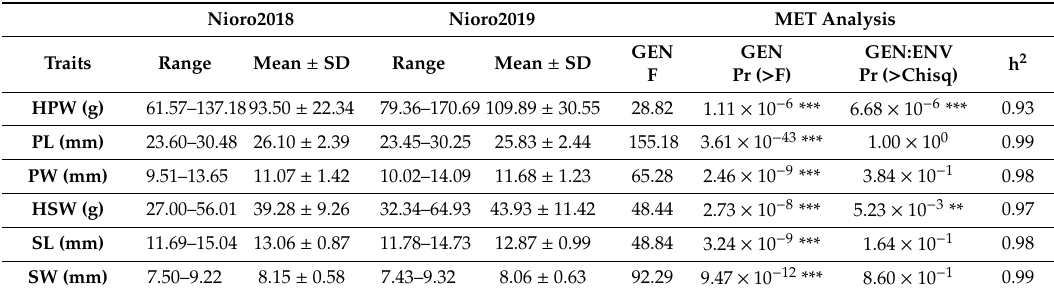
Table 2. Descriptive statistics NILs evaluation in Nioro in 2018 and 2019 and ANOVA table of multi-environment mixed-model analysis.